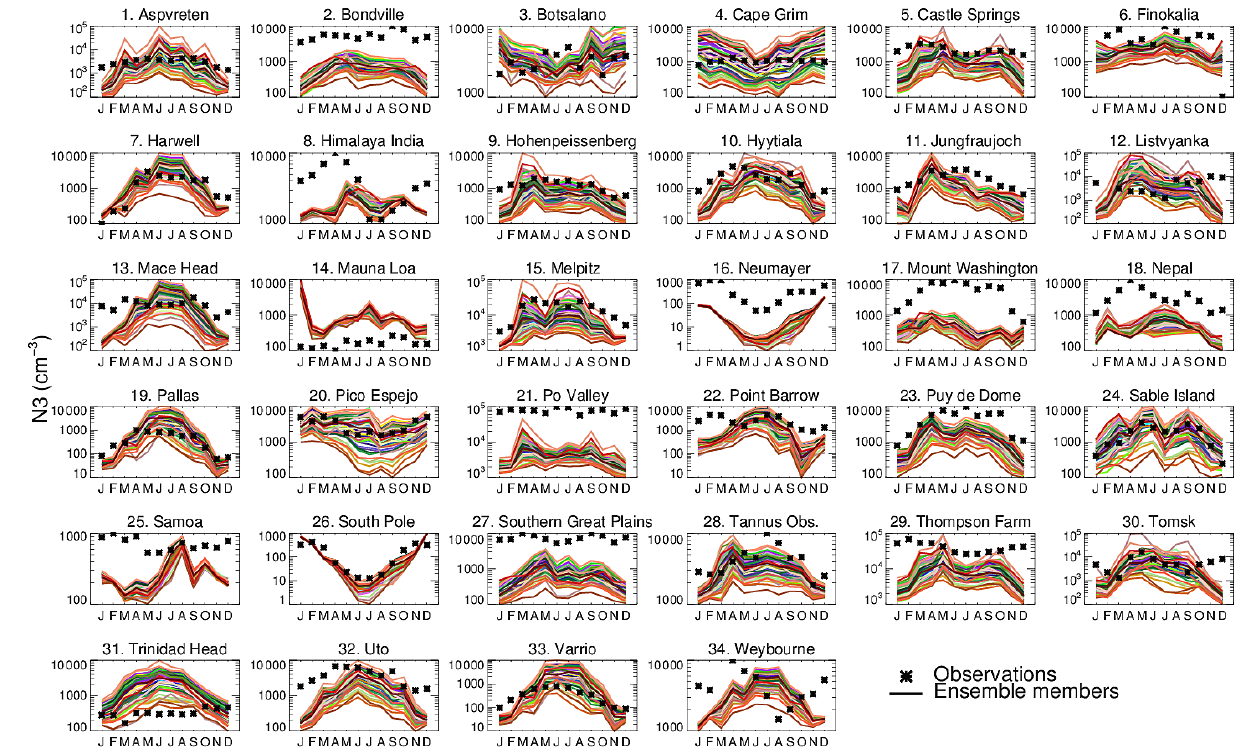
Figure 8. Seasonal cycle of simulated (solid coloured lines) and observed (black stars) monthly mean surface-level N3 concentrations at 34 ground-based sites. Each coloured line is an ensemble